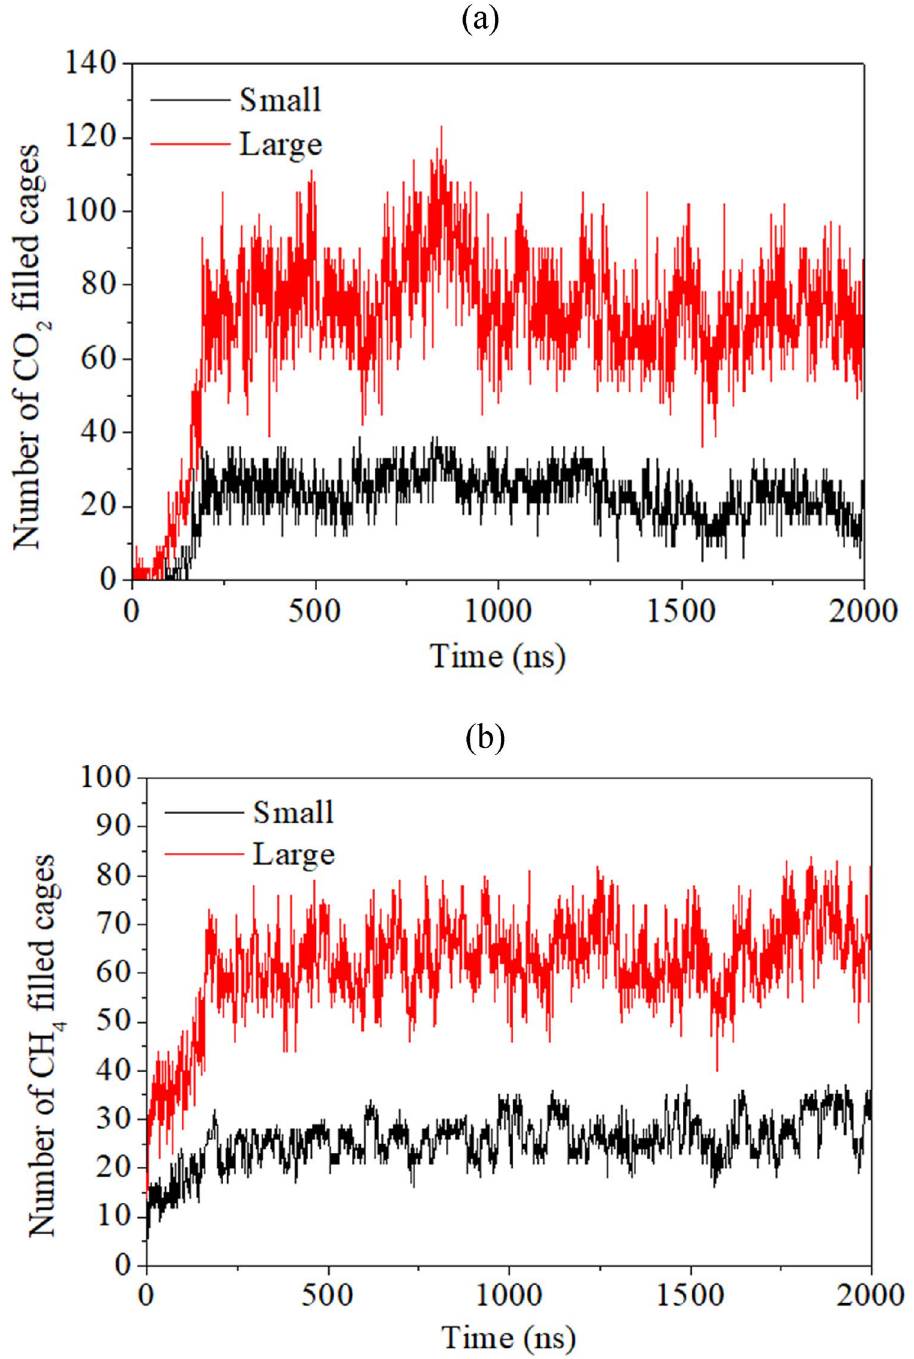
Figure 11. Plot of number of filled cages of ( a ) CO 2 and ( b ) CH 4 hydrates during the CH 4 –CO 2 replacement dynamics in presence of free water molecules, carbon dioxide and salt ions at operating temperature and pressure of 260 K and 10 MPa, respectively.